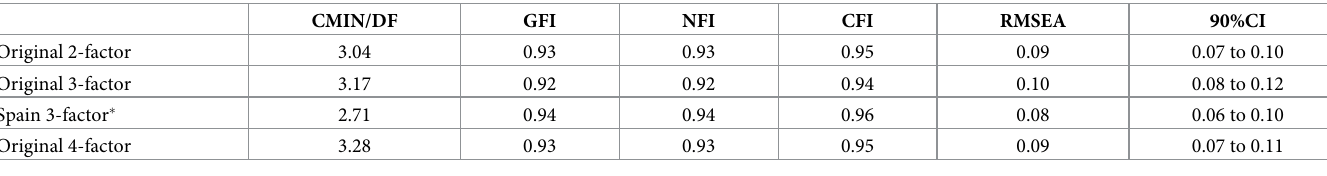
Table 4. Goodness-of-fit parameters of the CFA for all models considered, n =